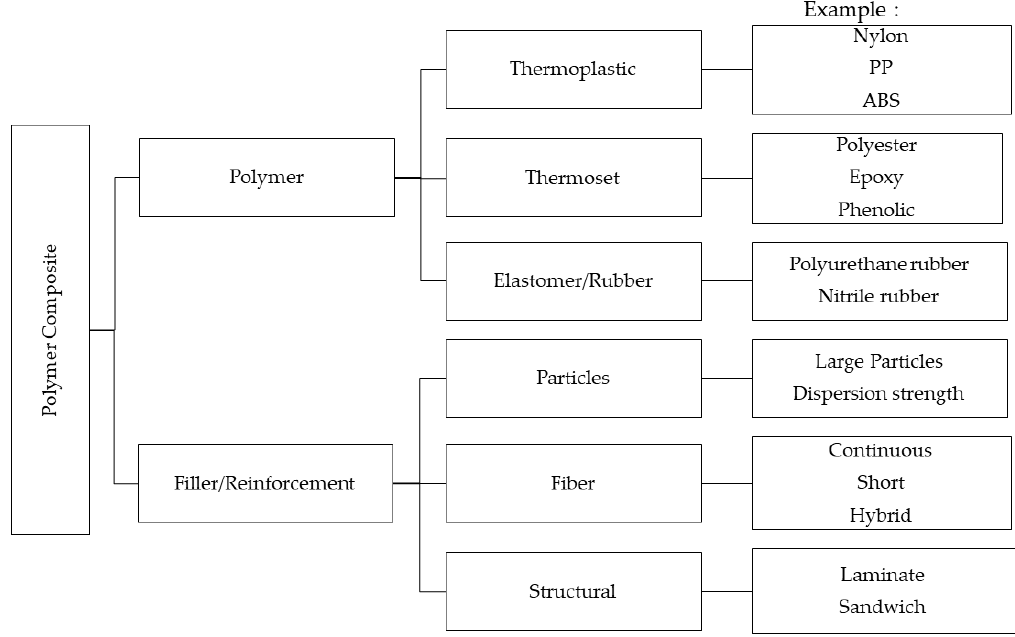
Figure 1. Polymer composite and types of matrix and filler.